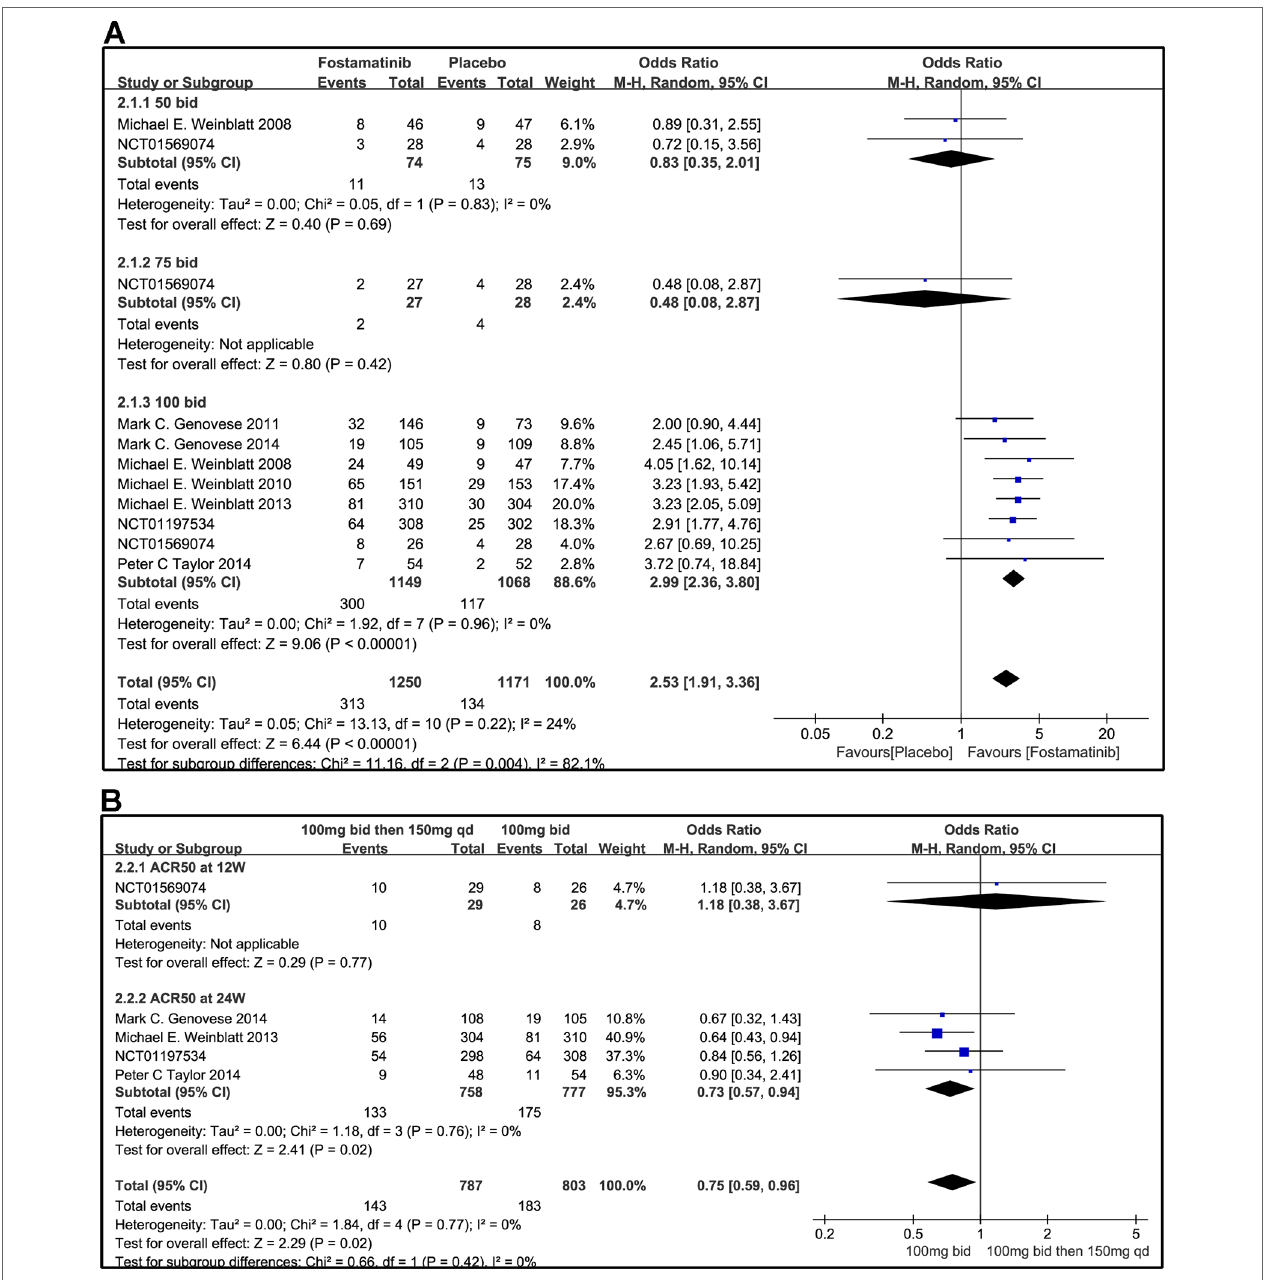
FIGURE 4 | Forest plots for the effect of multiple doses on ACR50 at different time points. (A) Subgroups administered multiple doses (50, 75, and 100 mg bid) of fostamatinib vs. placebo at 24 weeks from baseline; (B) 100 mg bid for 4 weeks followed by 150 mg bid vs. 100 mg bid at 12 and 24